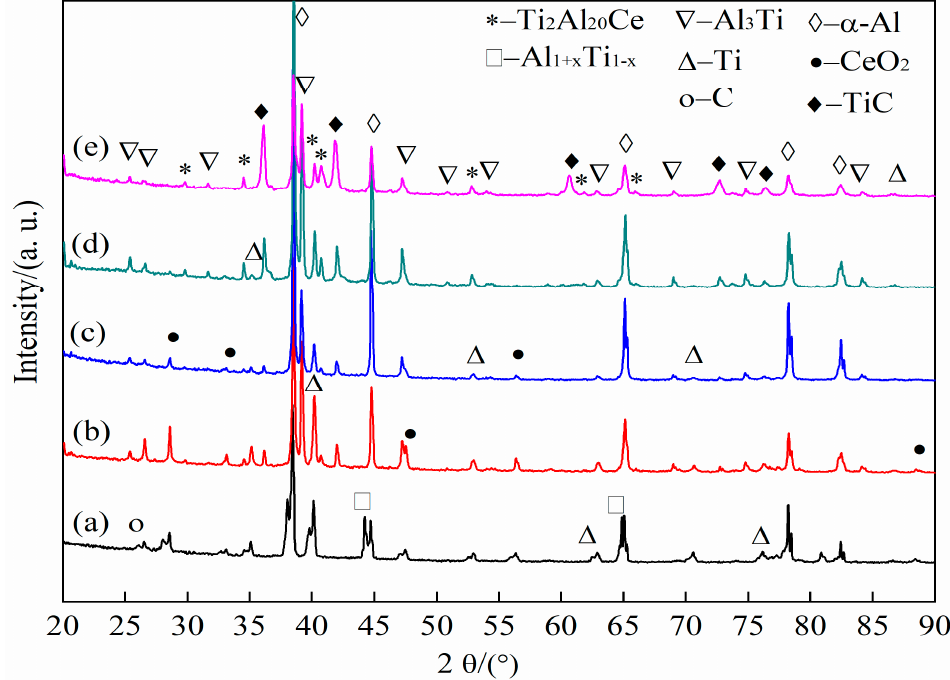
Figure 8. XRD spectra of prefabricated blocks with CeO 2 particle size of 2–4 μ m at different reaction times: ( a ) 8, ( b ) 50, ( c ) 60, ( d ) 80, ( e ) 90 s.